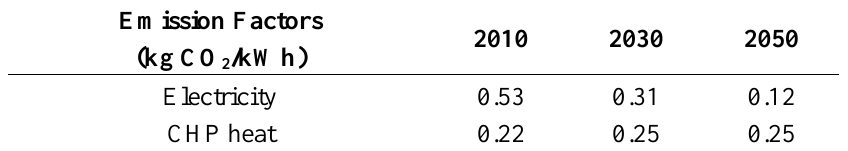
Table 4. Emission factors for electricity and heat. Source: own calculations based on [32,33].